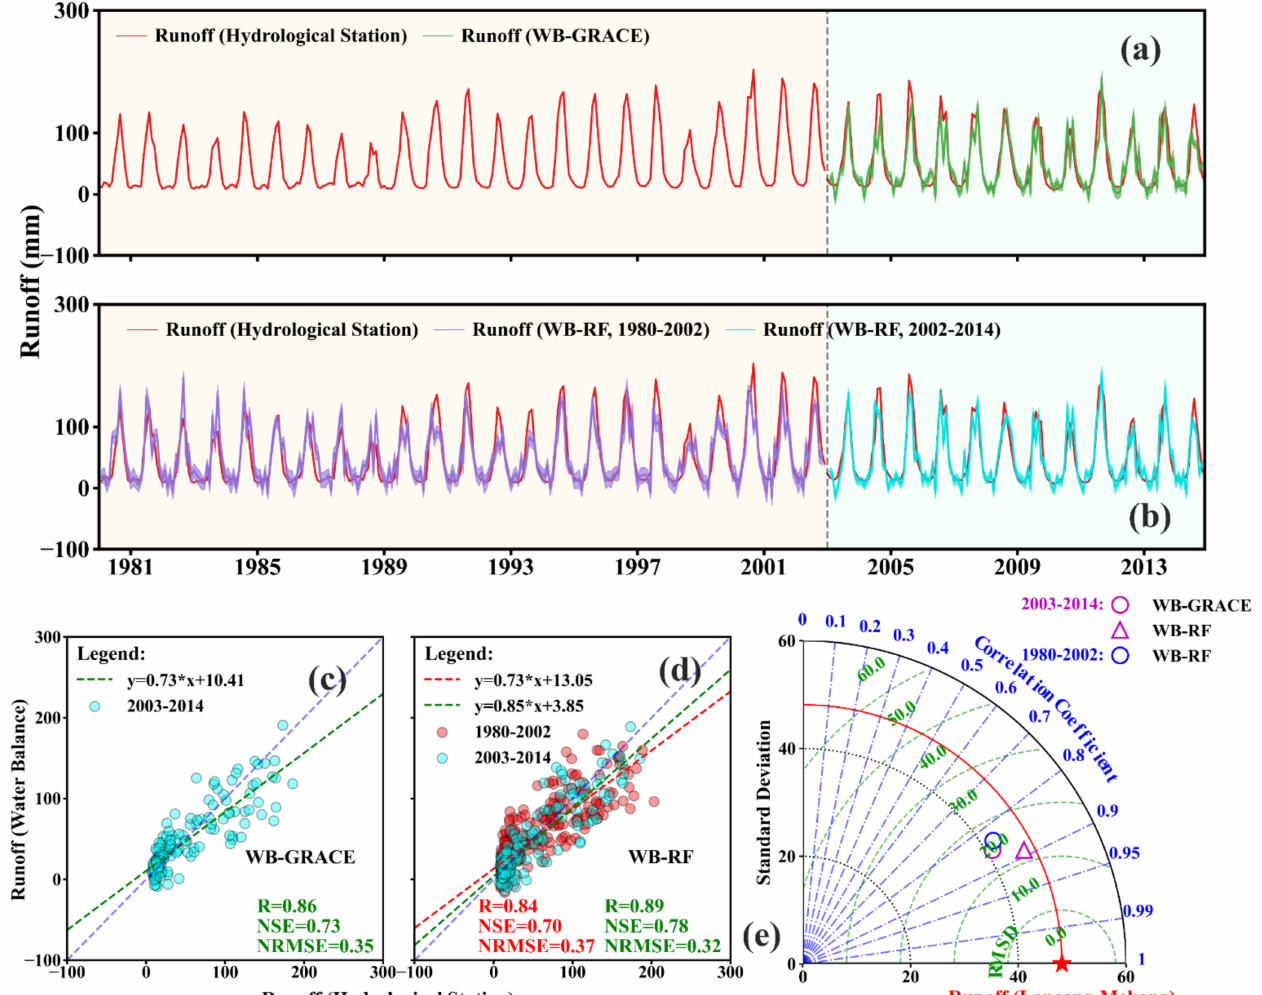
Figure 9. Comparison between the estimated discharge (WB-GRACE, WB-RF) and the observed discharge in the Lancang- Mekong River basin during 1980–2014. ( a , b ) refer to monthly estimated discharge time series using WB-GRACE and WB-RF, respectively, and the shades represent the uncertainty of discharge. ( c , d ) are the scatter plots of the estimated discharge and observed discharge. The 1:1 line is blue, and the fitted lines are red (1980–2002) and green (2003–2014). ( e ) Taylor diagram for comparing the estimated discharge and observed